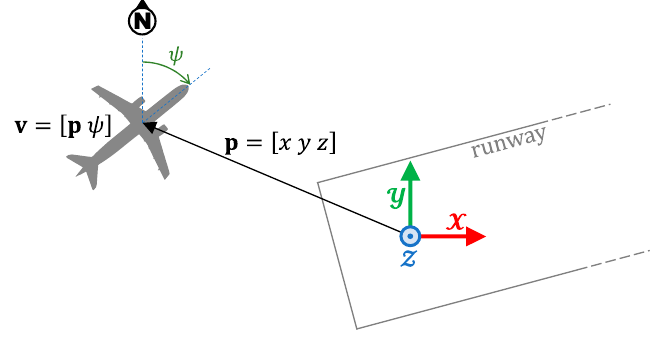
Figure 1. Airspace model.